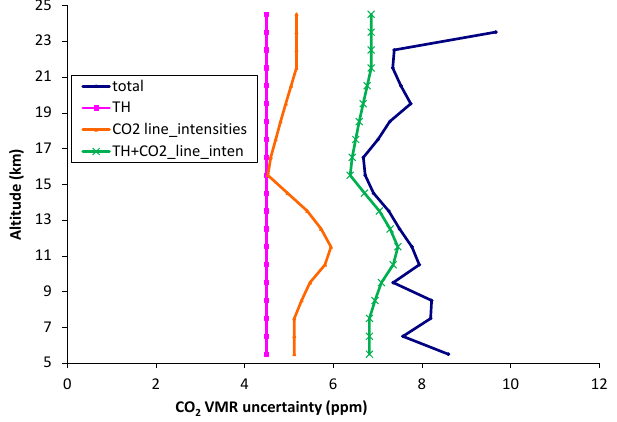
Figure 8. Total CO 2 error budget for CASS-FTS, plus domi- nant individual terms. TH uncertainty is labelled “TH”. The com- bination of TH and CO 2 line intensity uncertainties is labelled “TH + CO2_line_inten” and serves to demonstrate that these two sources of error account for the majority of the total